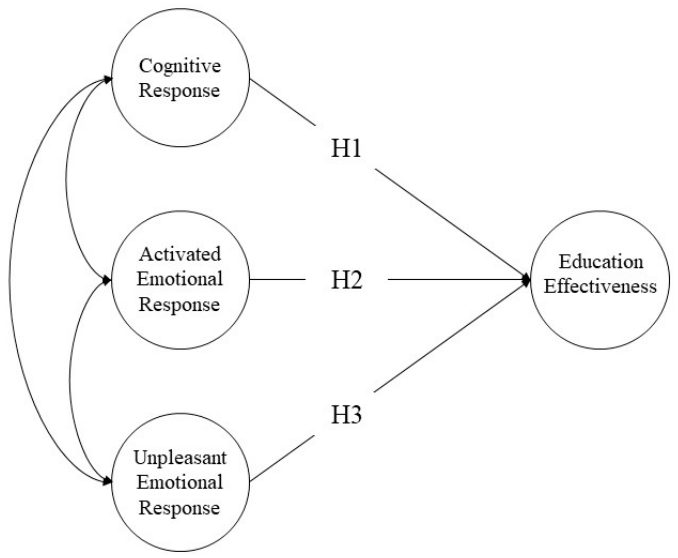
Figure 3. Structural Equation Model for Educational Effectiveness with Hypothesis (H).